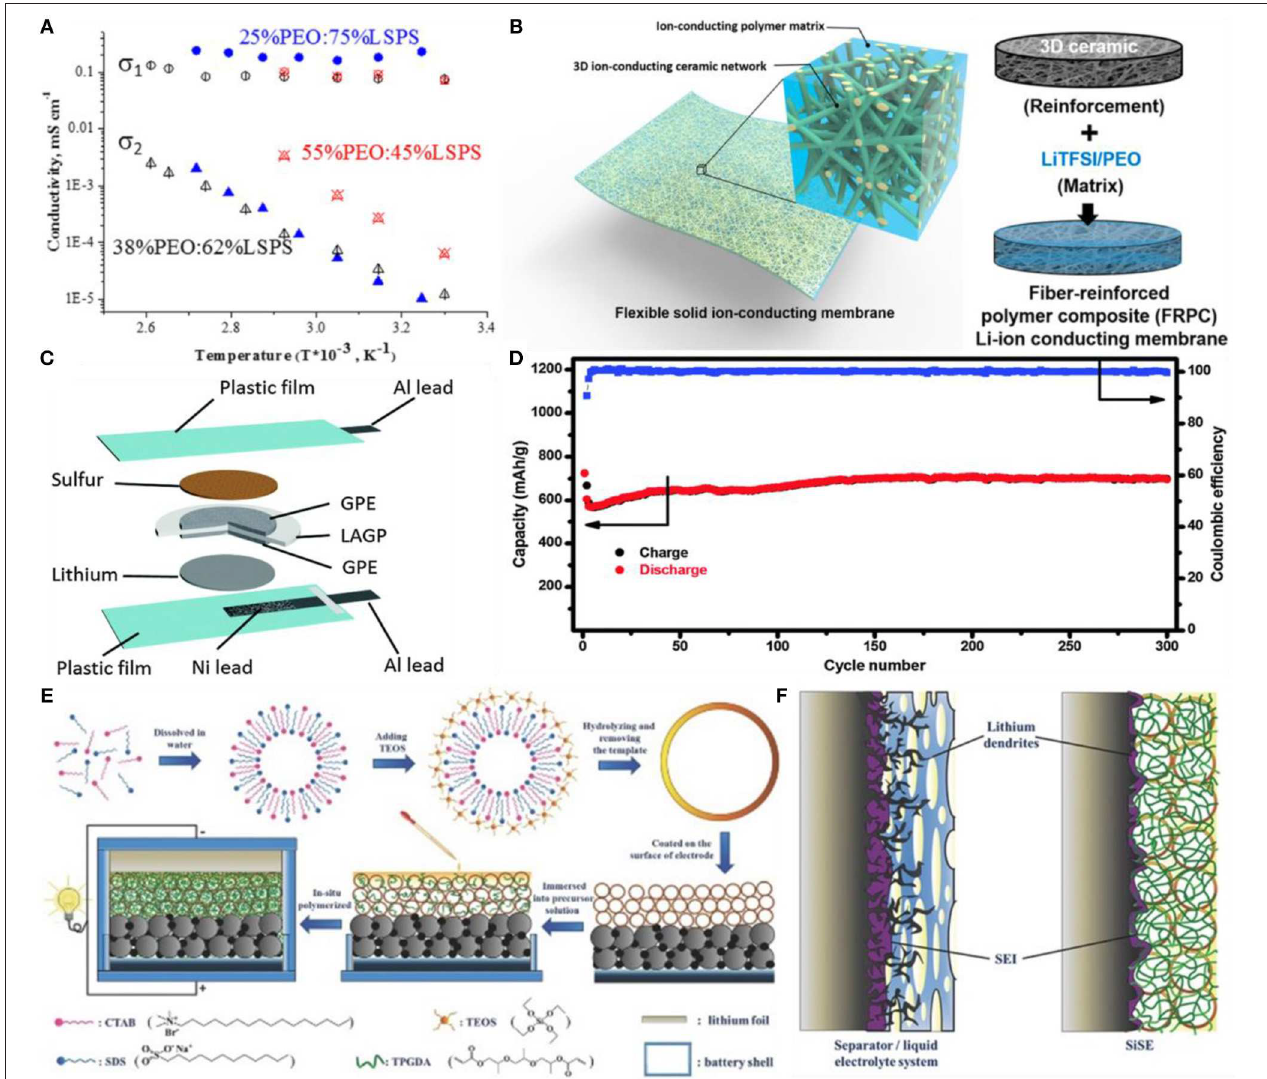
FIGURE 5 | Li-sulfur batteries based on the composite electrolyte. (A) Composite Li 10 SnP 2 S 12 -P(EO) 1.5 /LiI solid electrolytes with different LSPS/PEO ratios. Reproduced with permission (Fu et al., 2016). Copyright 2016, Journal of Solid State Electrochemistry. (B) Schematic of the hybrid solid-state composite electrolyte with 3D ceramic backbone. Reproduced with permission (Xia et al., 2017). Copyright 2016, Proc Natl Acad Sci. (C) Schematic illustration for the fabrication of the Li–S cell. (D) Long-term cycle life of the Li-S cell at 1/2C. (C,D) Reproduced with permission (Zhou et al., 2016). Copyright 2016, Chemical Communications. (E) Schematic illustration for the preparation route of SiSE. (F) The suppression mechanism for Li dendrite growth by capitalizing on SiSE as solid electrolyte. (E,F) Reproduced with permission (Wang Q. et al., 2017). Copyright 2016, Adv. Energy Mater.